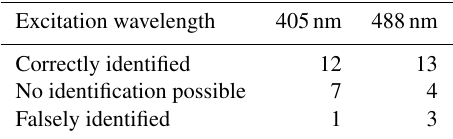
Table 2. Output of the wood species identification. Excitation wavelength 405nm